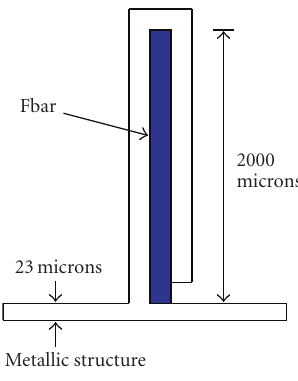
Figure 4: FBAR coupled to a hairpin with edge